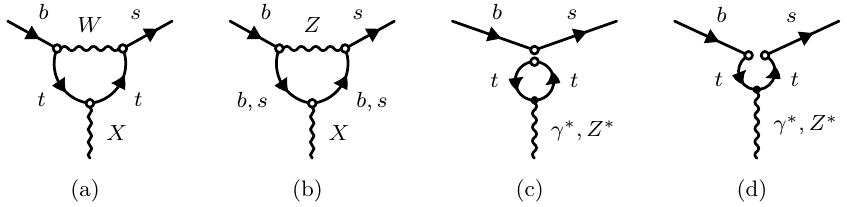
Figure 2 . Feynman diagrams for SMEFT-to-WET matching in b → s transitions at one-loop level. On the left we show possible two-quark operator insertions (circles) in a tW loop (a) and a sZ or bZ loop (b). Here X is either an on-shell photon or gluon ( C 7 , C 8 ) , or an off-shell photon or Z boson coupling to a muon pair ( C ) . On the right we show possible four-quark operator insertions. 9 , C 10 The two circles specify the quark currents. Contributions to C and C are due to F ( − ) and F (1) qq qu 9 10 (c), as well as F (3) qq